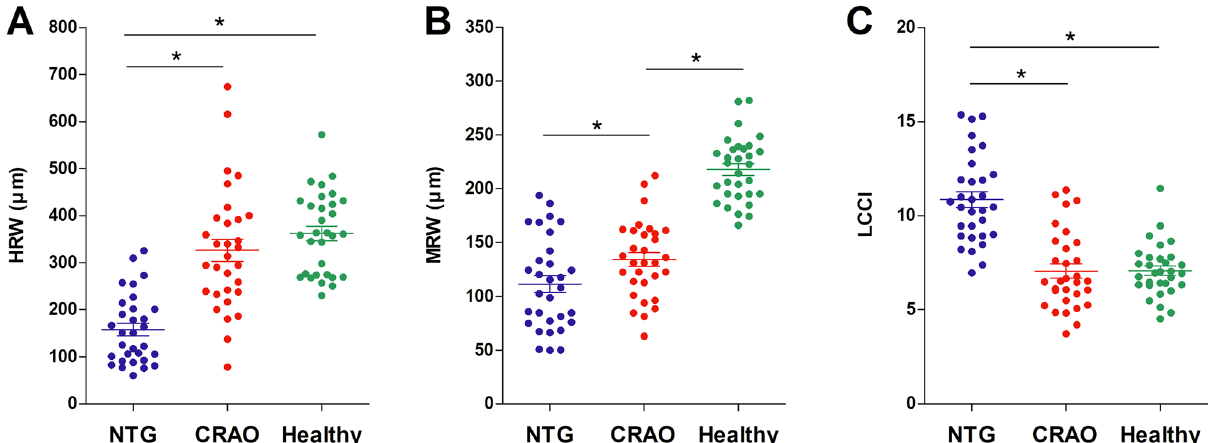
Figure 2. Scatterplots showing horizontal rim width (HRW) ( A ), minimal rim widths (MRW) ( B ), and lamina cribrosa curvature index (LCCI) ( C ) in eyes with normal tension glaucoma (NTG), central retinal artery occlusion (CRAO), and healthy contralateral eyes of subjects with CRAO. HRW and LCCI differed significantly in CRAO and NTG eyes, but did not differ in CRAO and healthy contralateral eyes ( A , C ). MRW differed significantly in the three groups ( B ). The horizontal bars represent the mean ± standard error of the mean. Asterisks indicate statistically significant differences ( P <